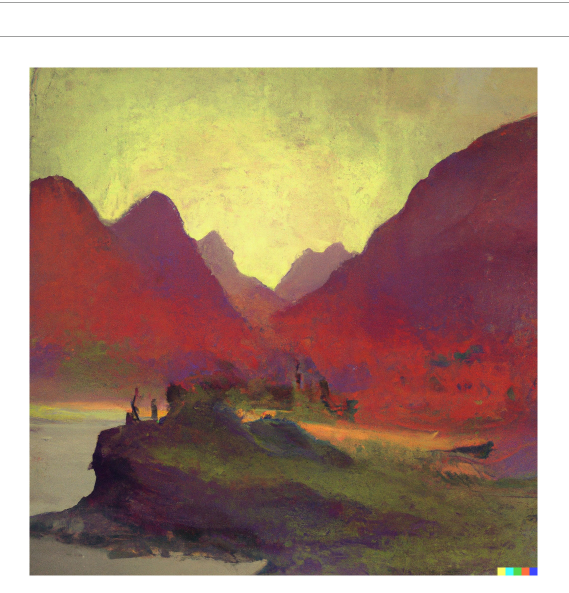
FIGURE6 Dall-E generated image to the prompt “a Surreal Impressionist Landscape that evokes the feeling of awe”.